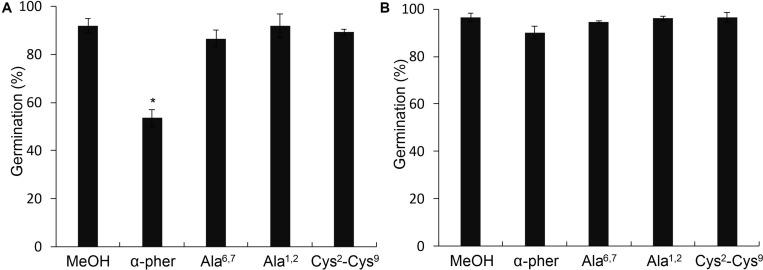
Germination of Fusarium oxysporum conidia. Germination at optimum concentration of inoculum (3.2 × 106 conidia/ml) of the F. oxysporum WT (A) or ste2Δ (B) conidia in the presence of 378 μM α-pheromone (α-pher), its mutated (Ala6,7, Ala1,2) or oxidized (Cys2-Cys9) versions or the solvent methanol (*P < 0.0001 versus MeOH for a given pheromone treatment).